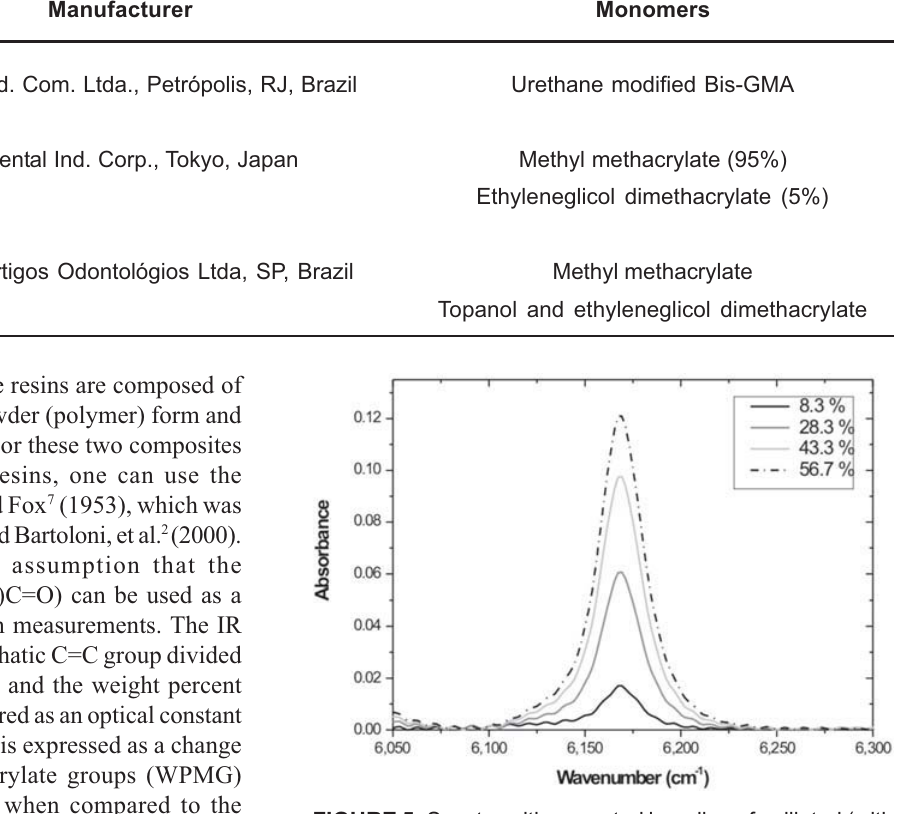
FIGURE 5- Spectra with corrected baseline of a diluted (with